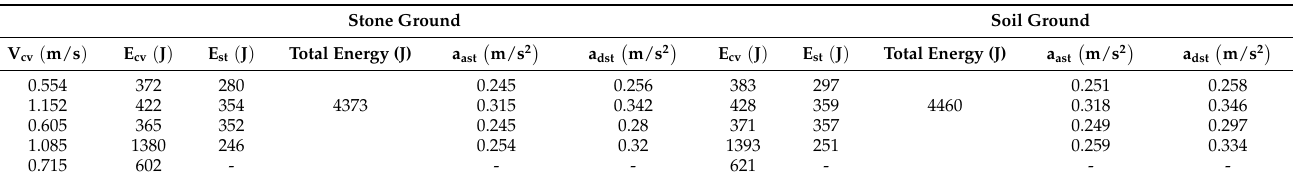
Table 5. Effect of ground friction.